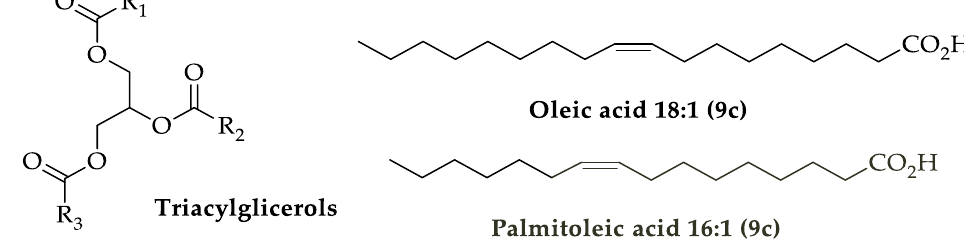
Figure 1. Triacylglycerols and some monounsaturated acids found in EVOO. Figure 1 . Triacylglycerols and some monounsaturated acids found in EVOO. variety of structurally distinct compounds as terpenes, sterols, and non-polar and polar phenols. Among them, phenols play a central role for human health, countering non- vitamin E, which contribute to protect cells from oxidative processes